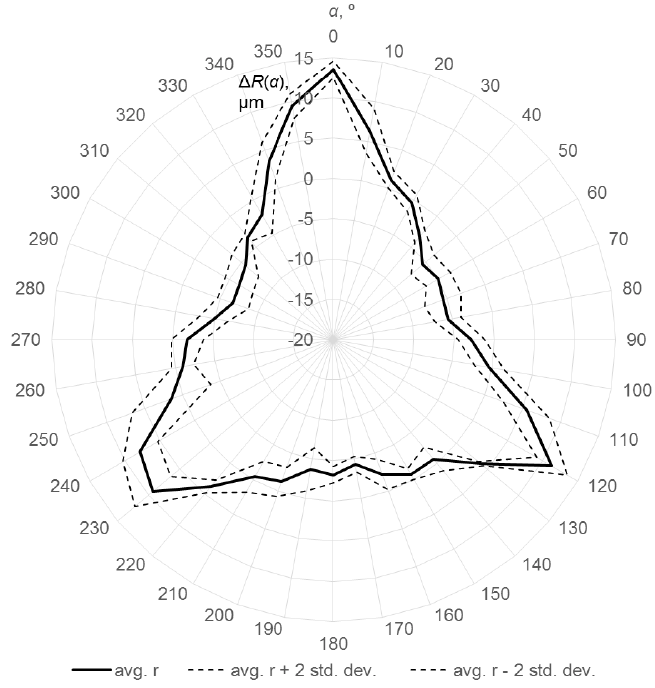
Figure 6. Results obtained on the machine tool for ultra-compact touch-trigger probe with 100 mm stylus, for measurement speed equal to 150 mm/min.